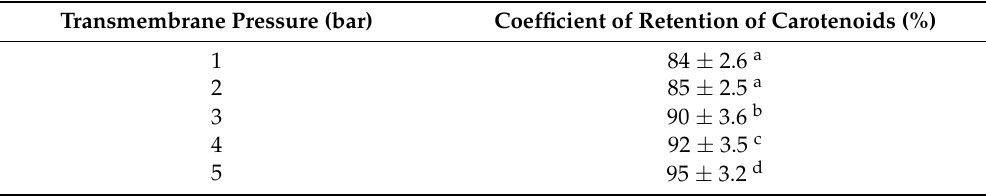
Table 6. Effect of TMP on coefficient of retention of total carotenoids content (TCC) in retentate. Figure 15. Effect of transmembrane pressure on permeate flux of gac oil ( T = 30 °C; Membrane pore size = 100 nm).